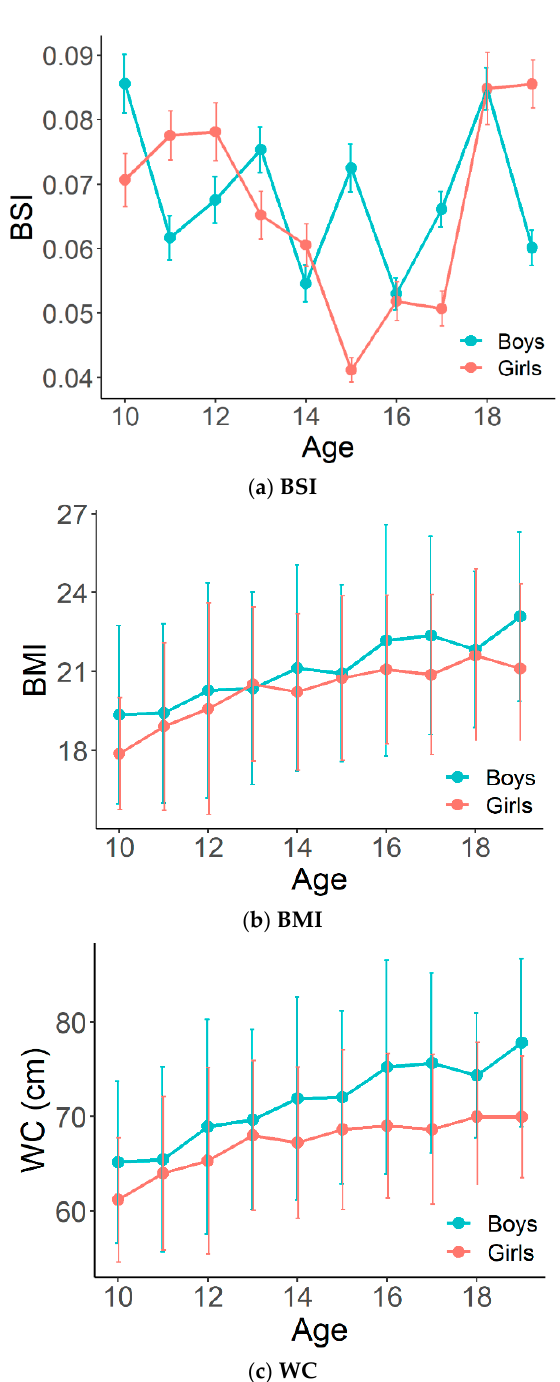
Figure 1. Means and standard deviations of BSI, BMI, and WC among boys and girls according to age. BSI body shape index, BMI body mass index, WC waist circumference.